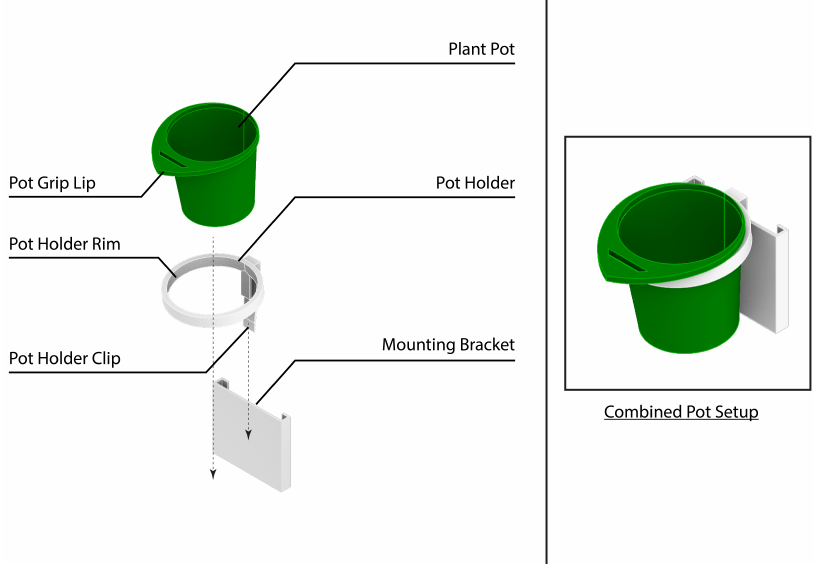
Figure 5. Assembly and parts of plant pot module.